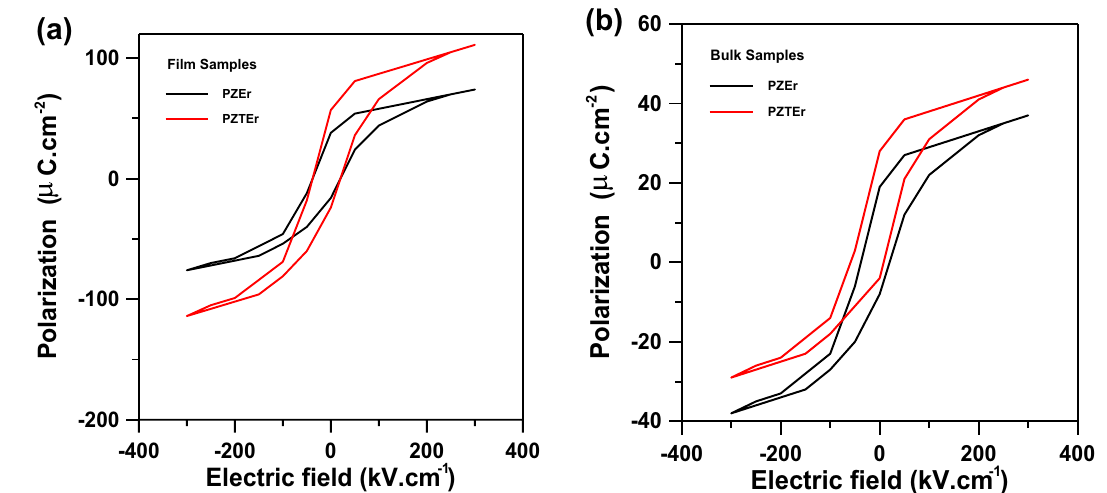
Figure 8. ( a ) P–E hysteresis loops of Er-doped PEZ and PEZT thin films. ( b ) P–E hysteresis loops of Er-doped PEZ and PEZT bulk